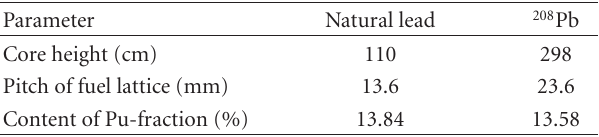
Table 4: Replacement of natural lead by 208 Pb: its influence on the reactor